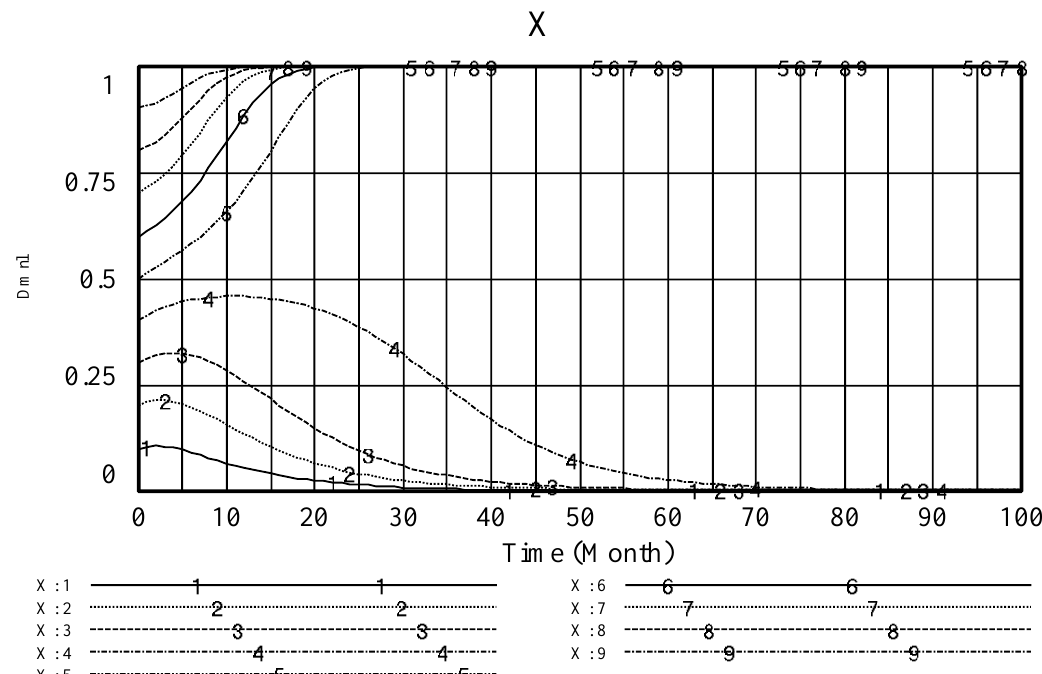
Int. J. Financial Stud. 2020 , 8 , x FOR PEER REVIEW Figure 3. Simulation result of x when initial value of y is 0.3. Figure 3. Simulation result of x when initial value of y is 0.3.